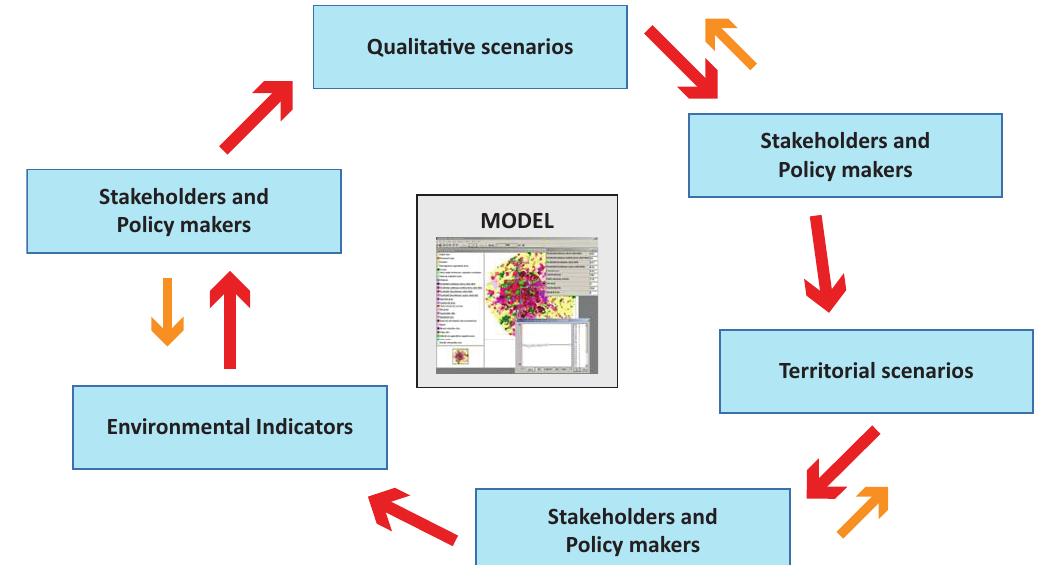
Figure 2. The model and the interrelation between stakeholders and policy